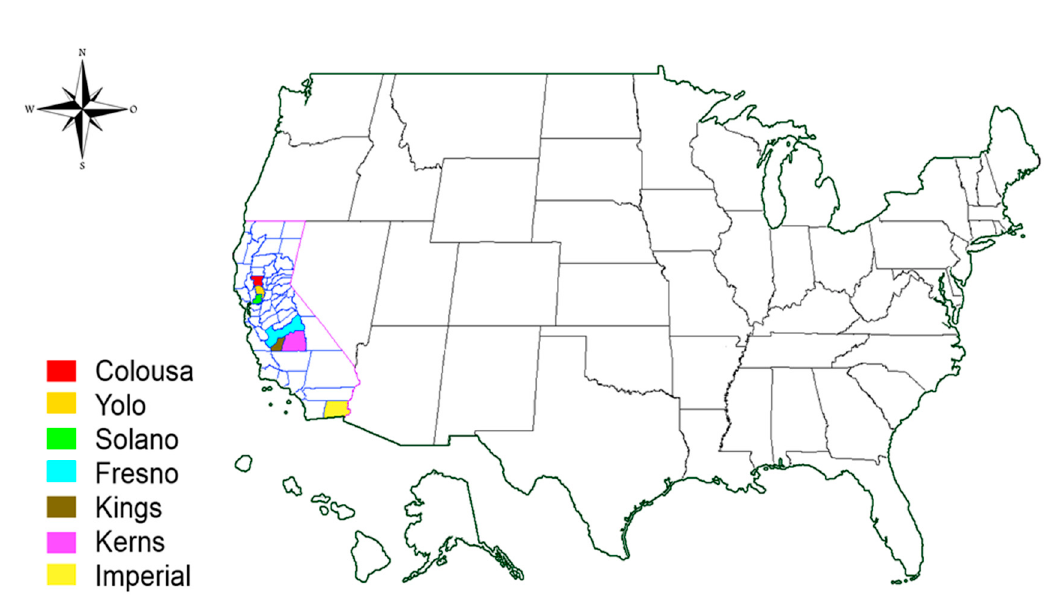
Figure 1. Locations of the case studies selected in California for the survey on sub-surface drip irrigation (SDI) conducted by researchers from University of California Cooperative Extension (UCCE).